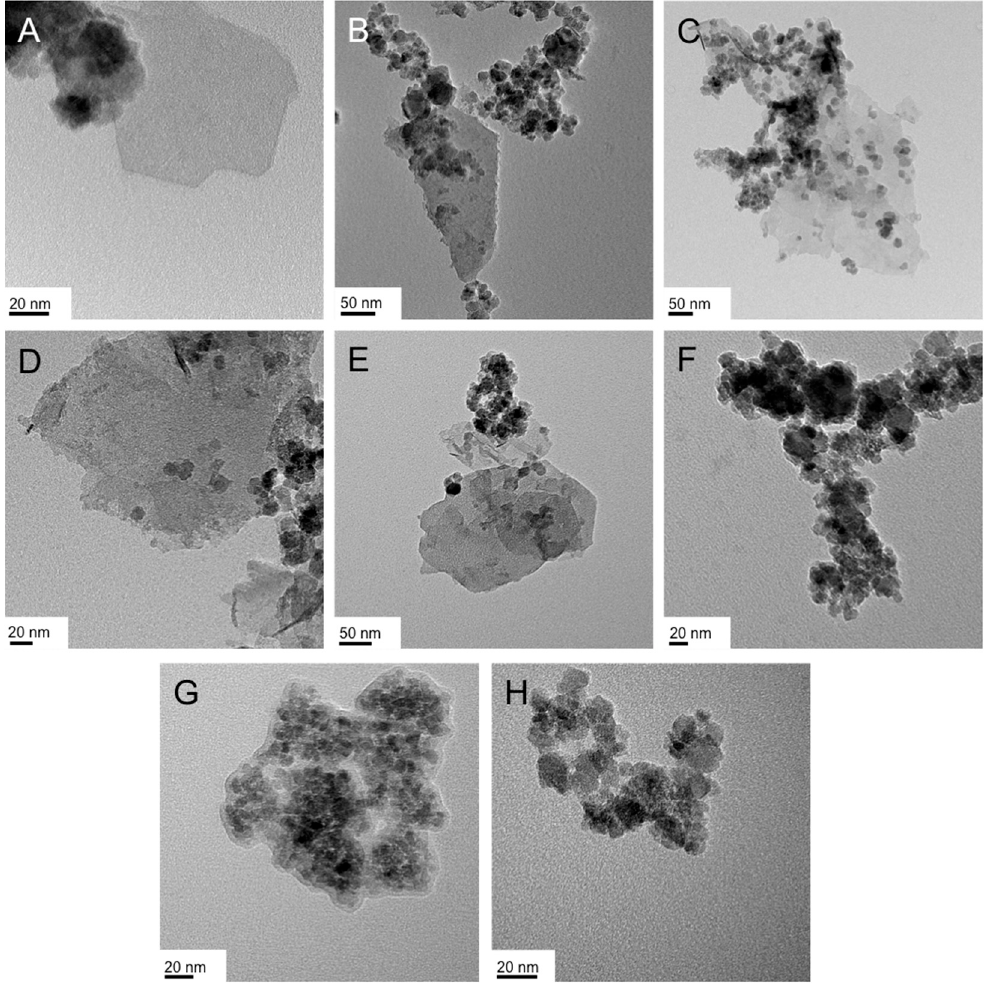
Figure 3. TEM images of the IO nanostructures obtained in the L α phase of Triton X-45 in water: ( A , B ) 50 wt % Triton X-45, 1 mmol FeCl 3 (( A ): froth, ( B ): gel); ( C , D ) 50 wt % Triton X-45, 2 mmol FeCl 3 (( C ): froth, ( D ): gel); ( E , F ) 20 wt % Triton X-45, 1 mmol FeCl 3 (( E ): froth, ( F ): gel); ( G , H ) 50 wt % Triton X-45, 1 mmol Fe(acac) 3 (( G ): froth, ( H ): gel).